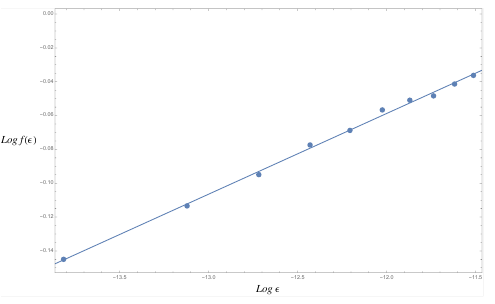
Figure 10 . The uncertain fraction with h = 1 . The axes are given by the natural